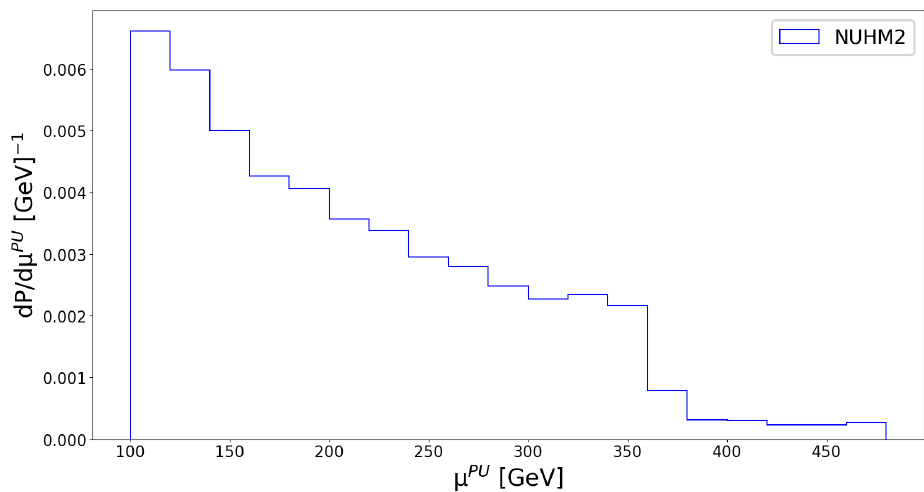
Figure 8. Distribution of µ parameter from scan over NUHM2 model with P µ ∼ 1 /µ and with m PU < 4 m OU and with other parameters fixed as in figure Z Z